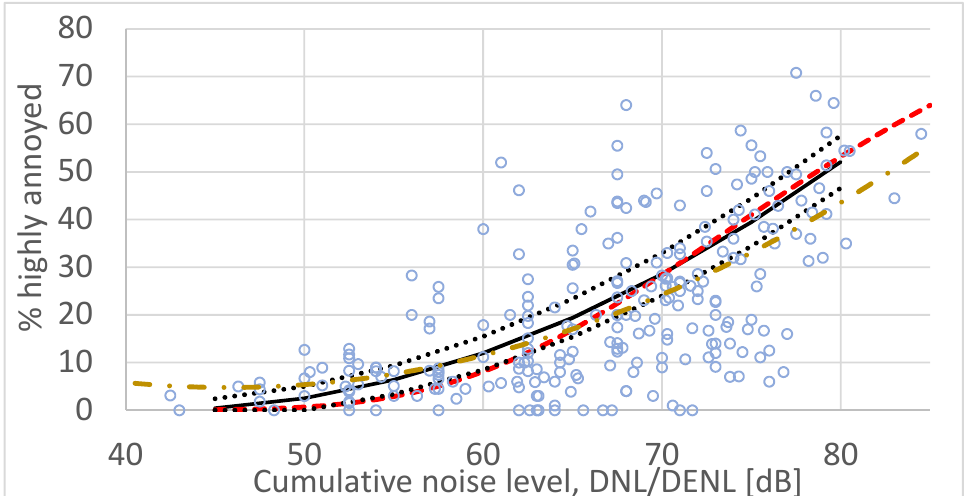
Figure 1. Set of paired exposure/annoyance observations from 26 surveys on road traffic noise (Miedema and Vos data set). Solid line (black) is the exposure–response function (ERF) with corresponding 95% confidence interval (black dotted) developed by Miedema and Vos. Standard second order polynomial regression yields the dash–dot ERF (yellow) while community tolerance level—CTL analysis yields the dashed ERF (red).